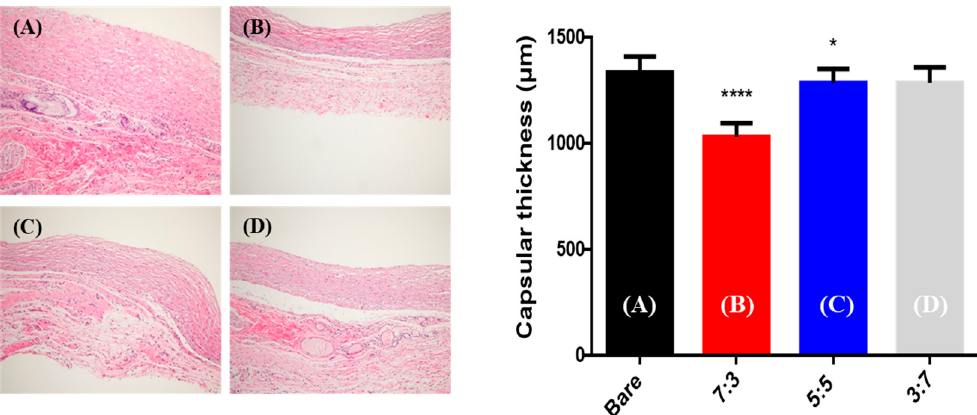
Figure 10. Histologic images of capsular tissue and bar graphs indicating thickness of capsules eight weeks after operation (hematoxylin and eosin staining, 200×). ( A ) Bare (control), ( B ) 7:3, ( C ) 5:5, and ( D ) 3:7 groups. (NS: not significant, * p < 0.05, **** p < 0.0001, Mann–Whitney test, com- pared to bare poly(dimethylsiloxane) (PDMS).)